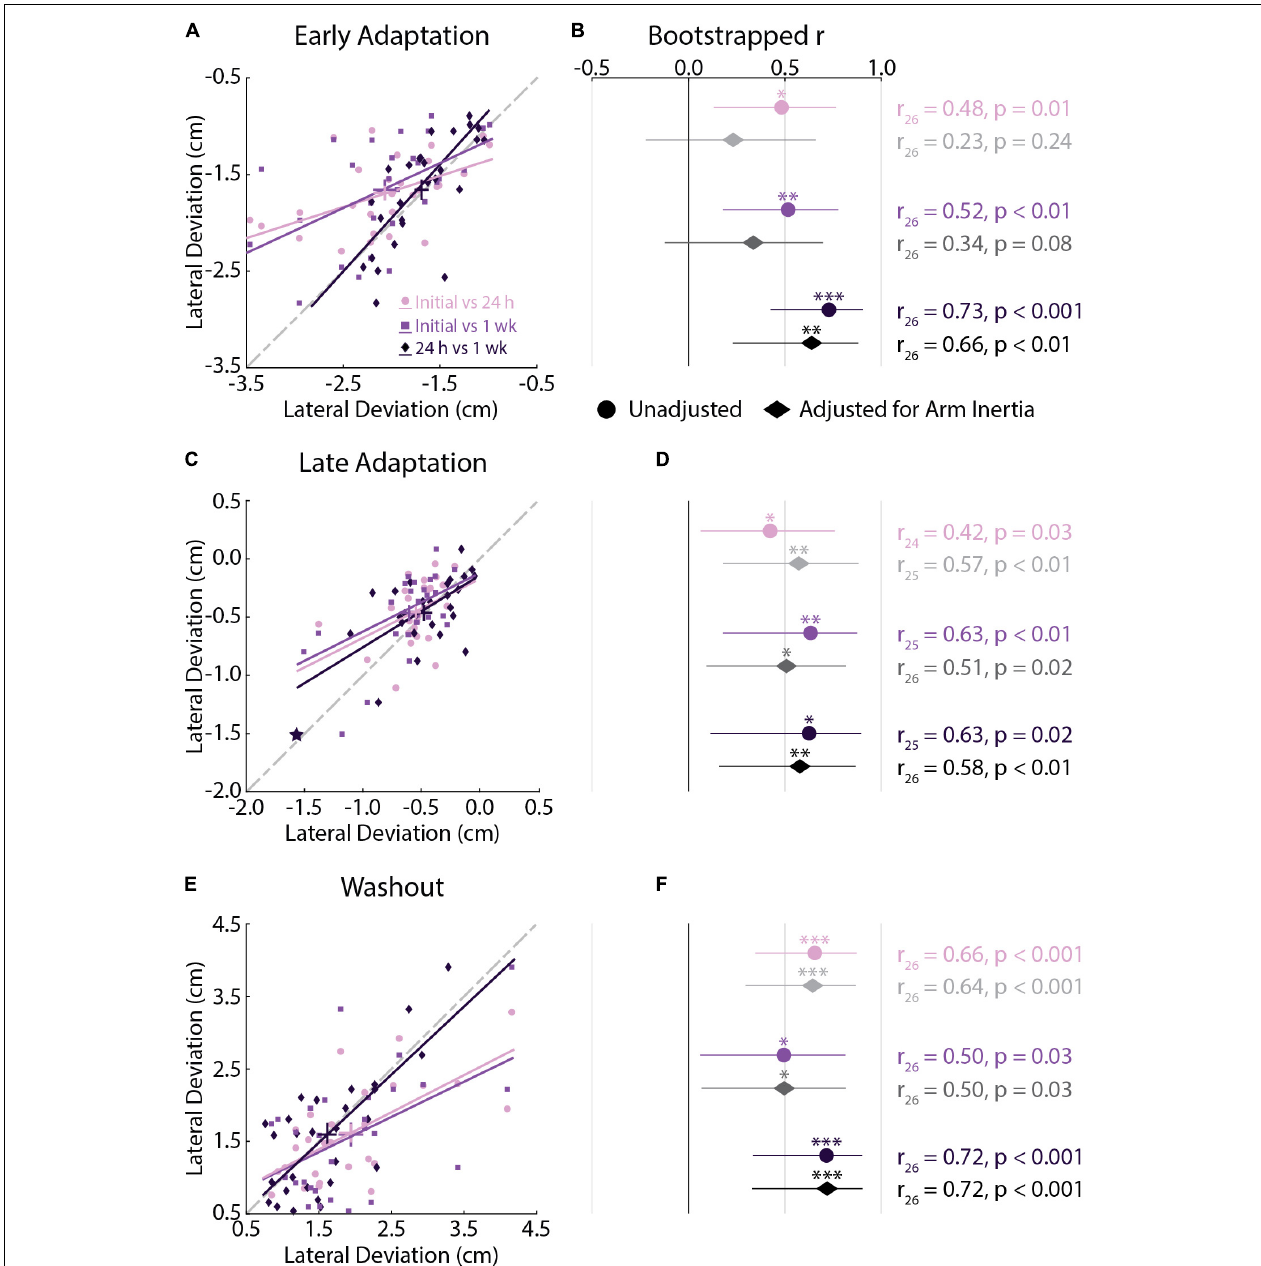
FIGURE 3 | Kinematic correlations across testing sessions ( Experiment 1 ). (A) Correlations between peak lateral deviations measured in Early Adaptation across all sessions. For each correlation, the earlier session is represented on the x -axis and later session on the y -axis. Bars represent the mean and SEM. Trendlines were obtained via robust linear regression and are used for visualization purposes. The dashed gray line represents unity. (B) Mean and 95% confidence intervals (CI) of the bootstrapped Pearson’s r distributions are shown for each correlation (circles) and for the partial Pearson’s correlations adjusted for arm inertia (diamonds). (C,D) Correlations between peak lateral deviations measured in Late Adaptation across all sessions. (E,F) Correlations between peak lateral deviations measured in Washout across all sessions. Data in panels (C–F) are presented in the same manner as panels (A,B) . (C) Star indicates the observation that did not reach the critical value for outlier detection. The correlation results were not different with and without this observation. ∗ p < 0.05, ∗∗ p < 0.01, ∗∗∗ p < 0.001 after Bonferroni corrections (corrected for 3 correlations).